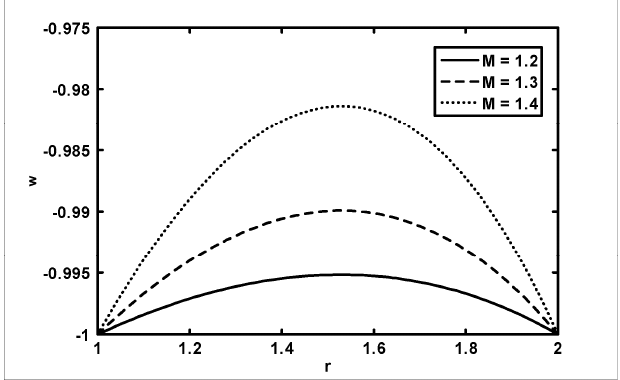
Figure 8. The variation of friction force F ( 1 ) (inner tube) with Q for di ff erent values of ϕ at r 1 = 0.1, M = 3, when µ = r .